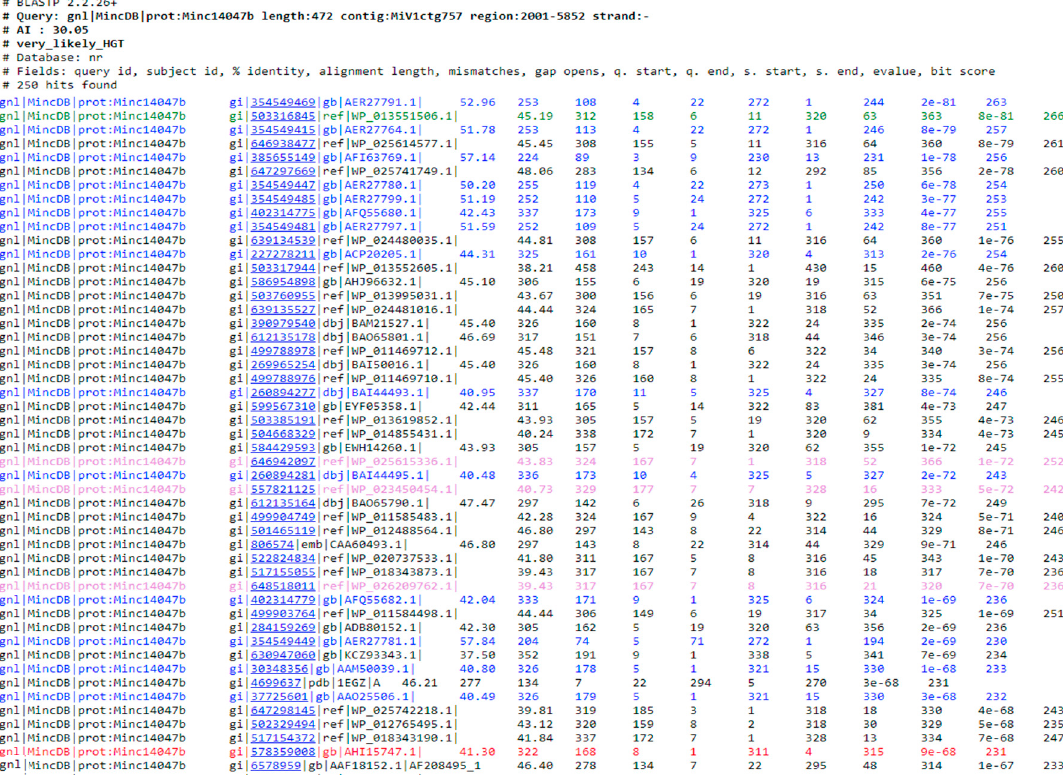
Figure 4. The color-coded BLAST results that can be explored from a web browser, color code and further explanations are detailed below.